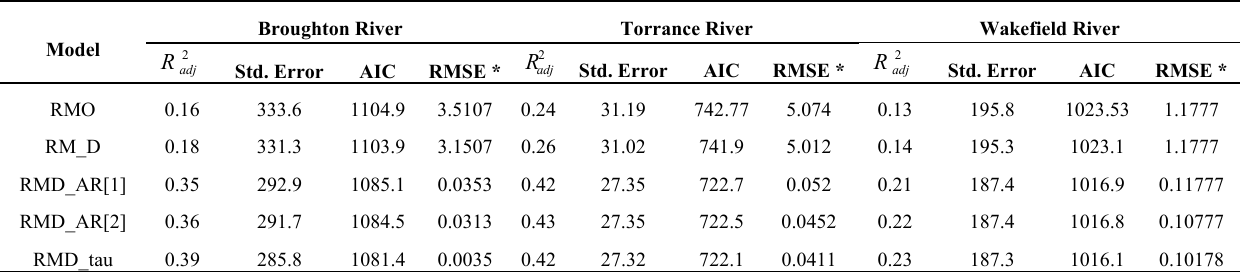
Table 5. Fitted regression model for Broughton River, Torrance River and Wakefield River. Broughton River Torrance River Model